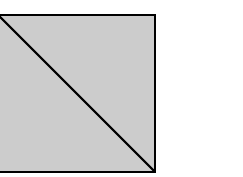
Figure 4. Same geometry, different meshes.